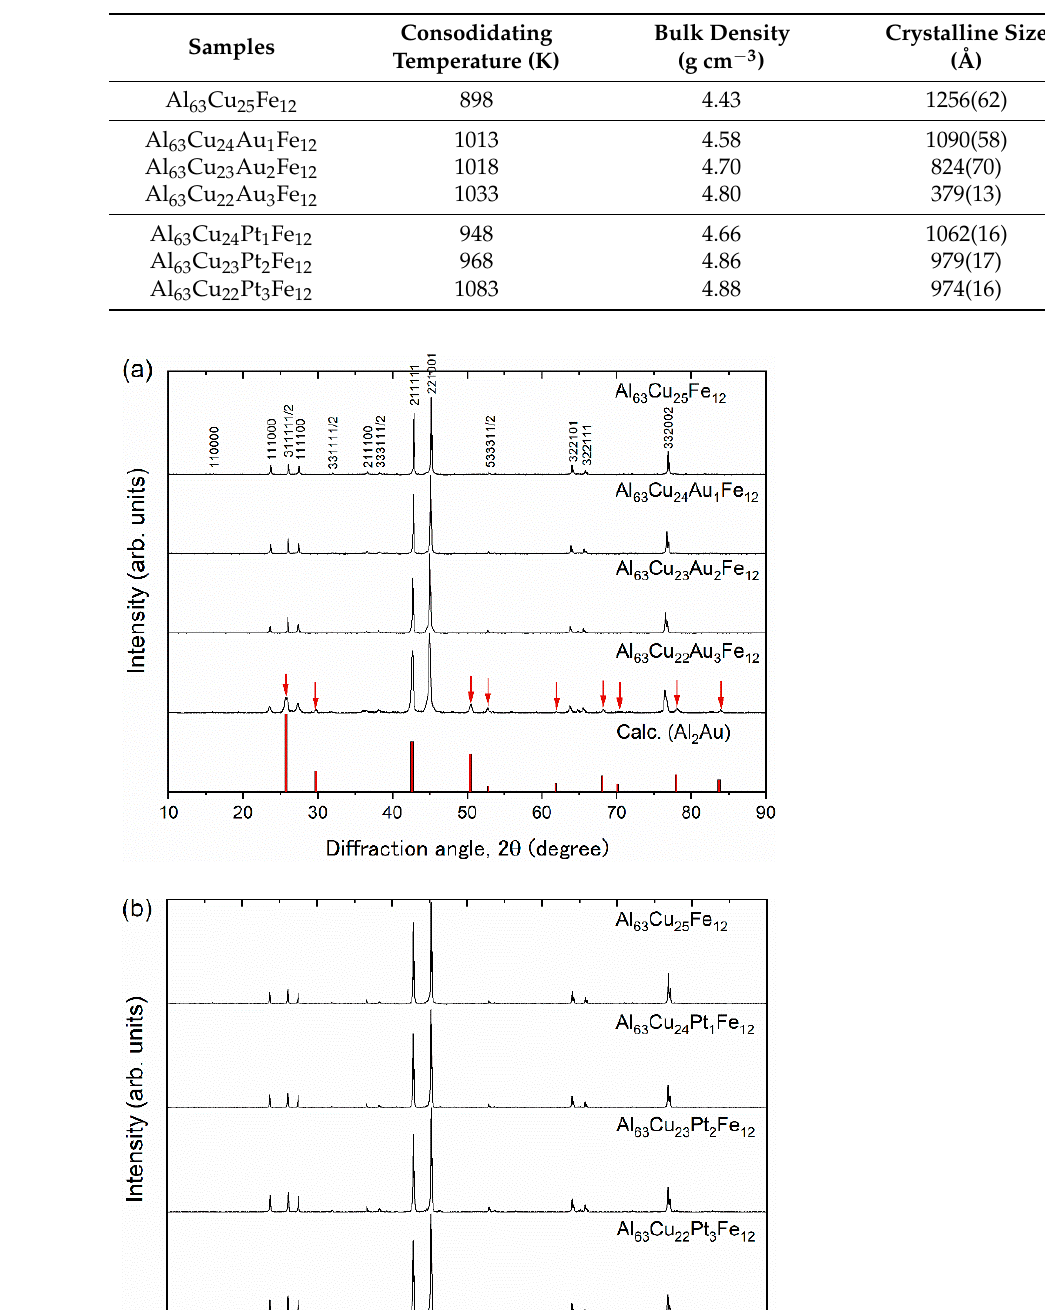
List of applied consolidating temperatures, bulk densities, crystalline sizes for